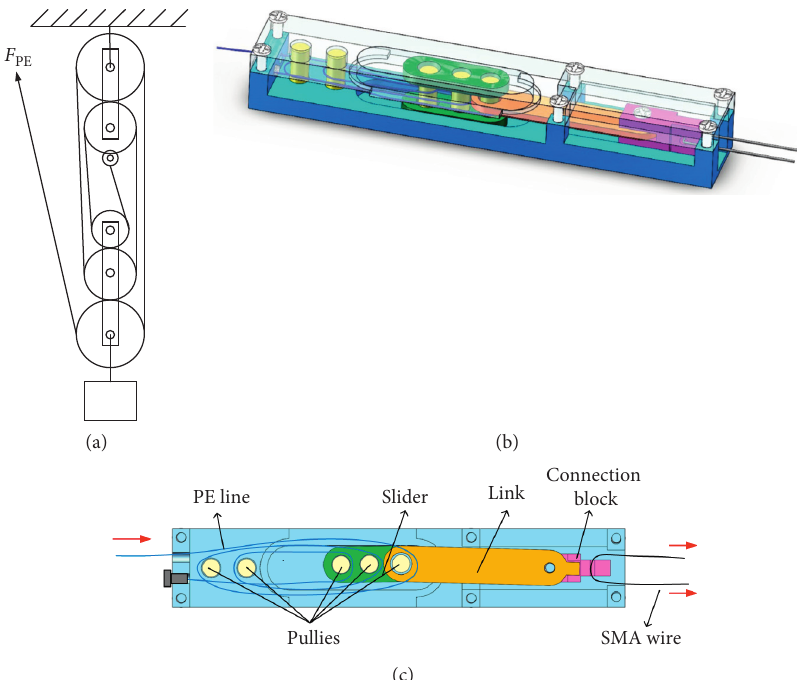
Figure 3: Schematic diagram of the range extender. (a) Schematic diagram of the pulley mechanism. (b) 3D view. (c) Section view.